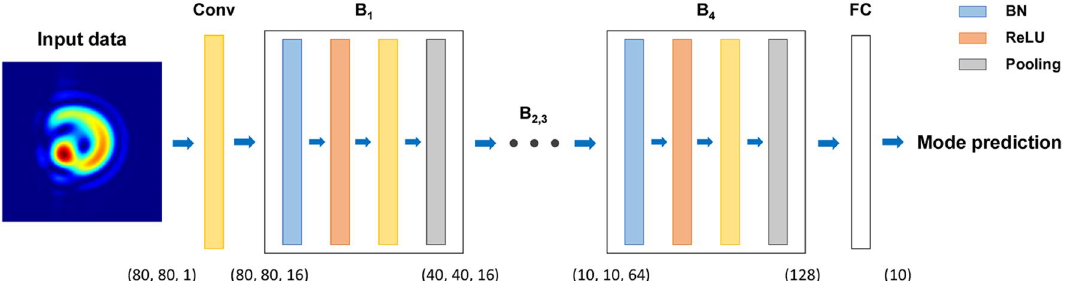
Figure 3. Schematic diagram of the ATANN: Conv, convolutional layer; B, convolution block; BN, batch normalization layer; FC, fully connected layer. Each block consists of BN, ReLU, Conv, and Pooling layers.